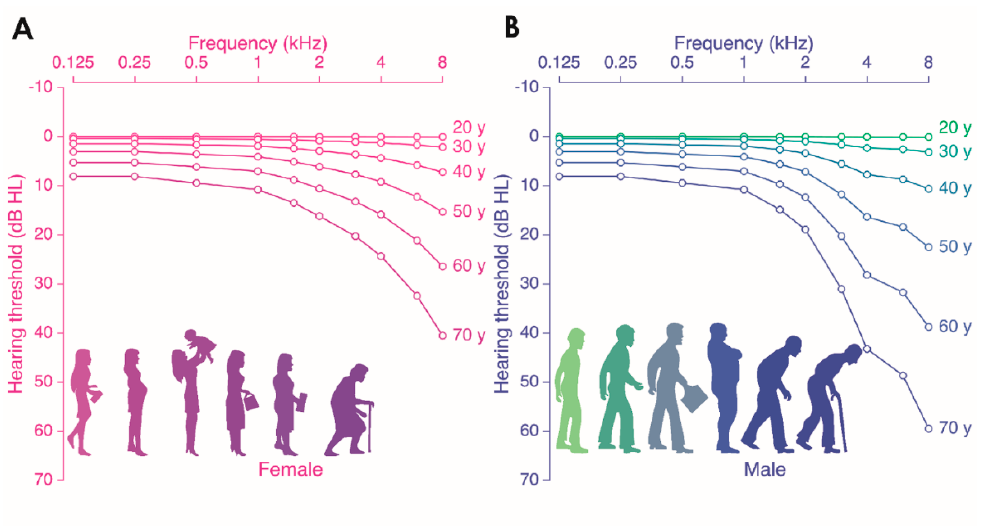
Figure 2. Age-related hearing loss according to the International Organization for Standardization (ISO) 7029 standard. Shown are audiograms for females ( A ) and males ( B ). The x -axis displays the pure tone frequency (Hz) and the y -axis the hearing thresholds (dB HL). Each individual graph is representative of the median audiogram at a particular age (ranging from 20 to 70 years old, with increments of 10 years).